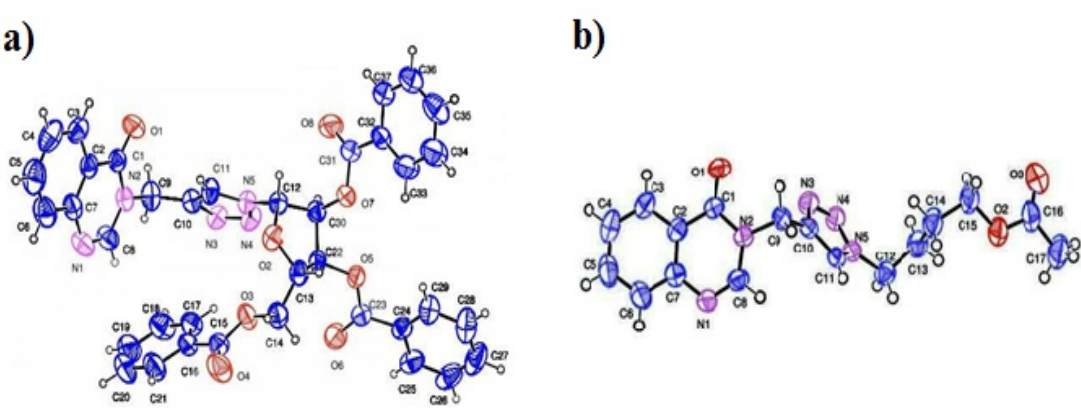
Figure 1. X-ray crystal structures of compounds ( a ) 6g and ( b ) 6i with the atom numbering used in the crystallographic